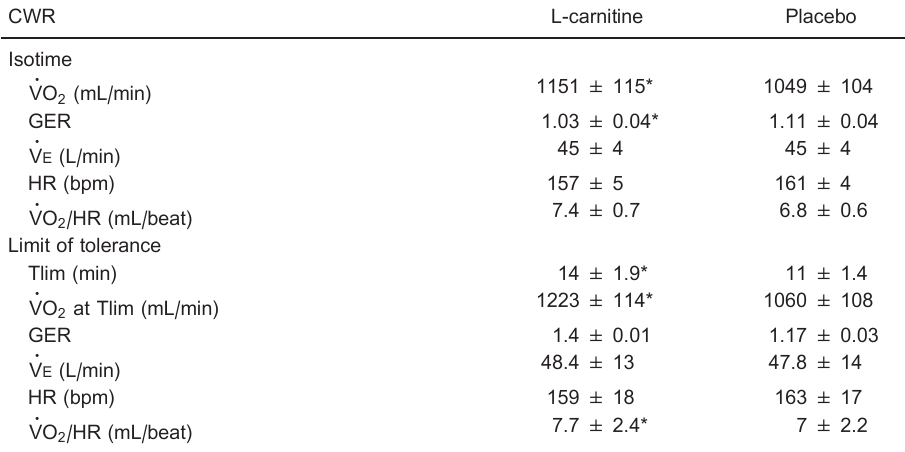
Table 6. Metabolic, ventilatory and cardiovascular exercise variables at constant work rate (CWR) exercise at isotime and limit of tolerance (Tlim) in mitochondrial myopathy patients after L-carnitine or placebo